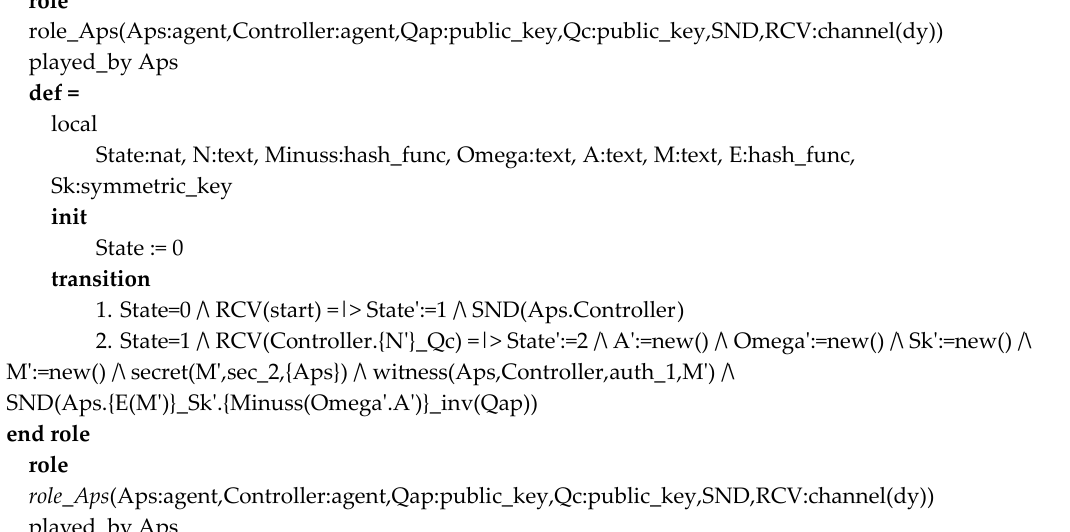
Algorithm A1 High level protocol specification language (HLPSL) code for application providers (Aps) role